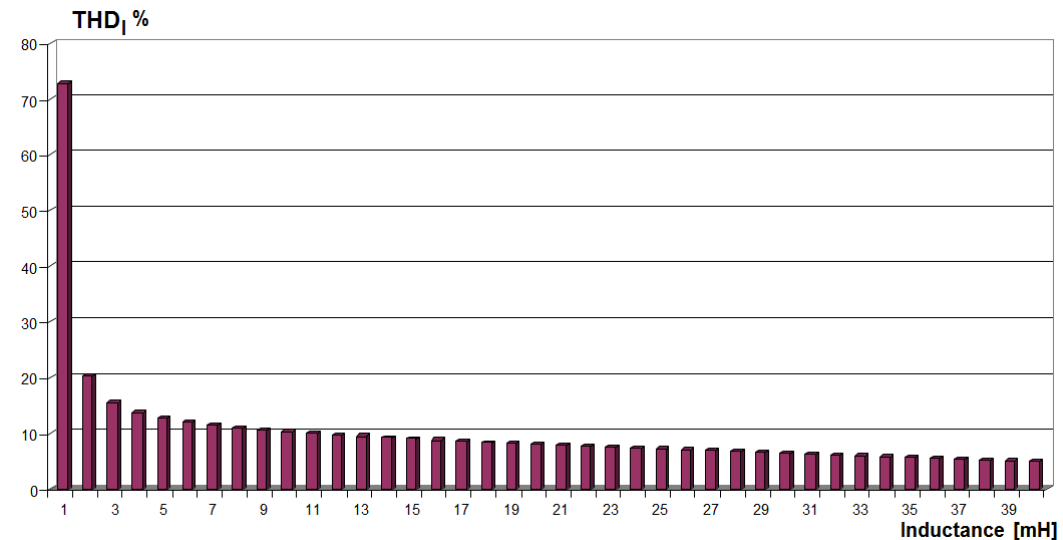
Figure 8. THD I factor as function of the reactor inductance L s .